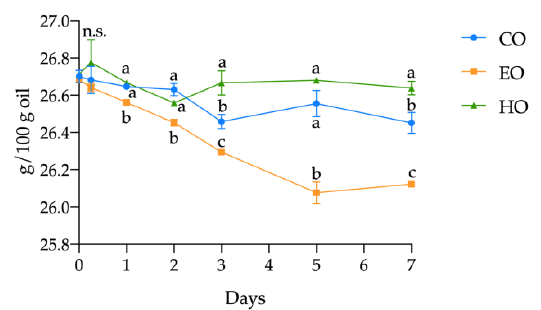
Figure 4. Kinetics of peroxide value (PV) (meq O 2 /kg oil) in stripped linseed oil without antioxidants (CO), with hemp extract (HO), and with α -tocopherol (EO) and results of ANOVA with Duncan’s test. Each point corresponds to the mean ± standard deviation ( n = 3). Different letters a,b within the same day mean significantly different results at p < 0.05 among different samples. n.s. = not significant. Figure 3. Kinetics of α -linolenic acid (ALA) in stripped linseed oil without antioxidants (CO), with hemp extract (HO), and with α -tocopherol (EO) during the storage treatment. For each point (mean ± standard deviation of three independent replicates), results of ANOVA with Duncan’s test are reported between the samples within the same day. Different letters a–c mean the results were significantly different at p < 0.05. n.s. = not significant.